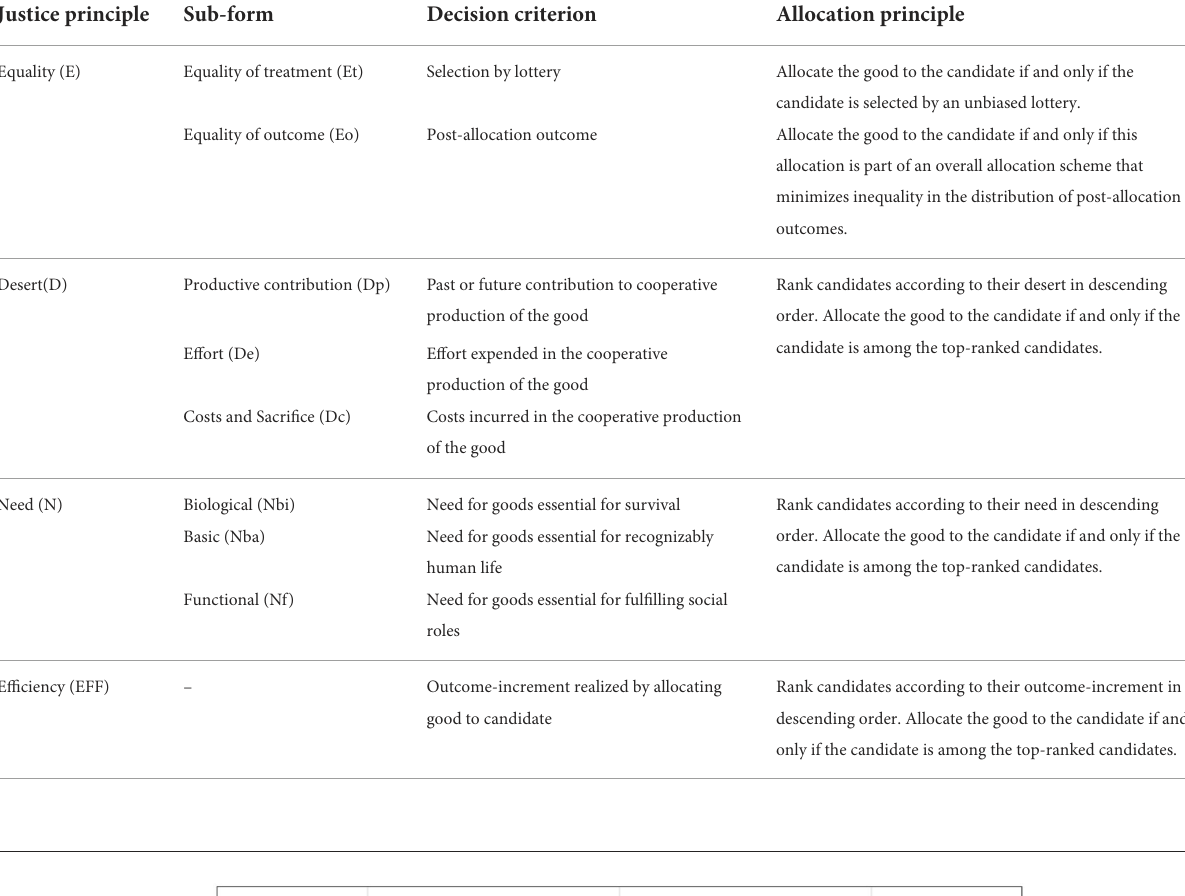
TABLE 1 Middle-range distributive justice principles.